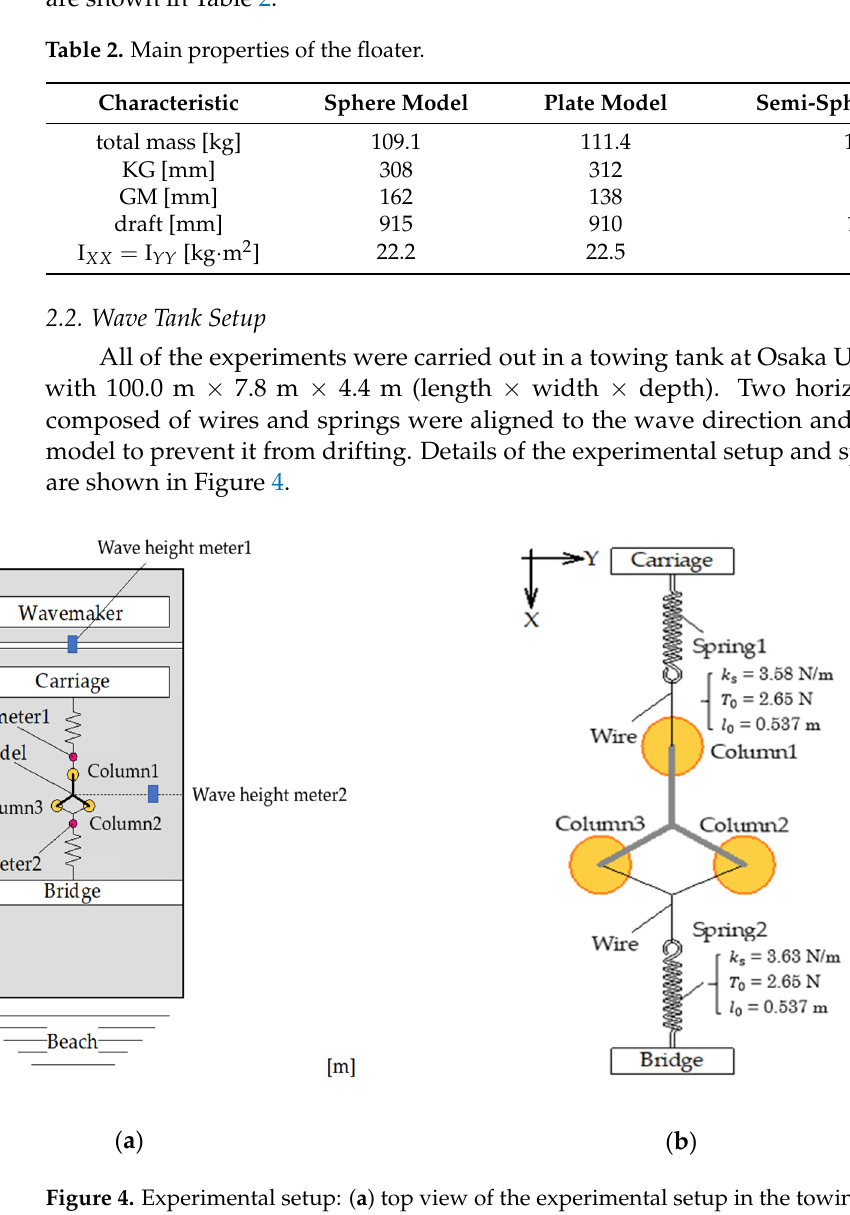
Figure 4. Experimental setup: ( a ) top view of the experimental setup in the towing tank; ( b ) details of the top view of the mooring line settings. of the top view of the mooring line